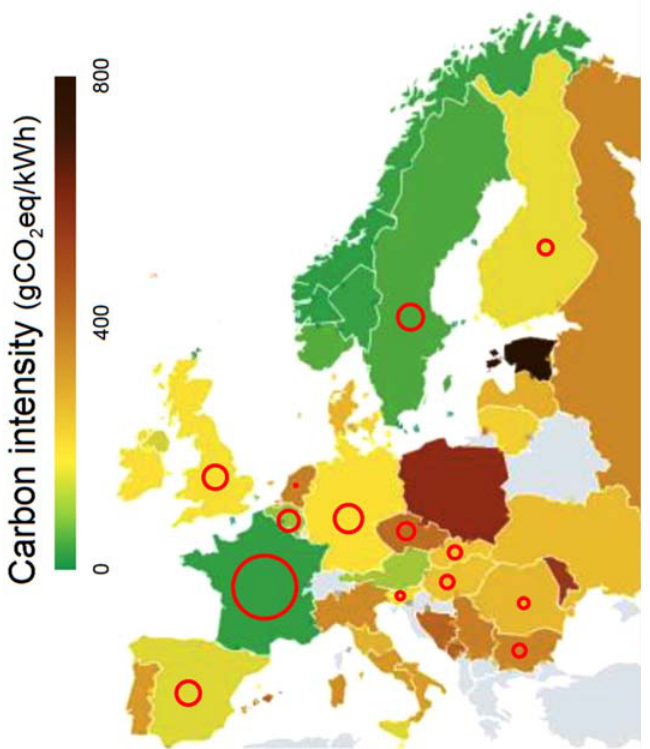
Fig. 1. – Carbon intensity of electricity generation in the European Union countries provided by the electricityMap application (available at https://www.electricitymap.org ) at 10:35 a.m. on 25 September 2019. The area of the circles is proportional to the heat produced by nuclear power plants in the 14 Member States where the nuclear option is part of the energy mix (going from ∼ 1 . 2 PWh/year in France to ∼ 9 . 2 TWh/year in the